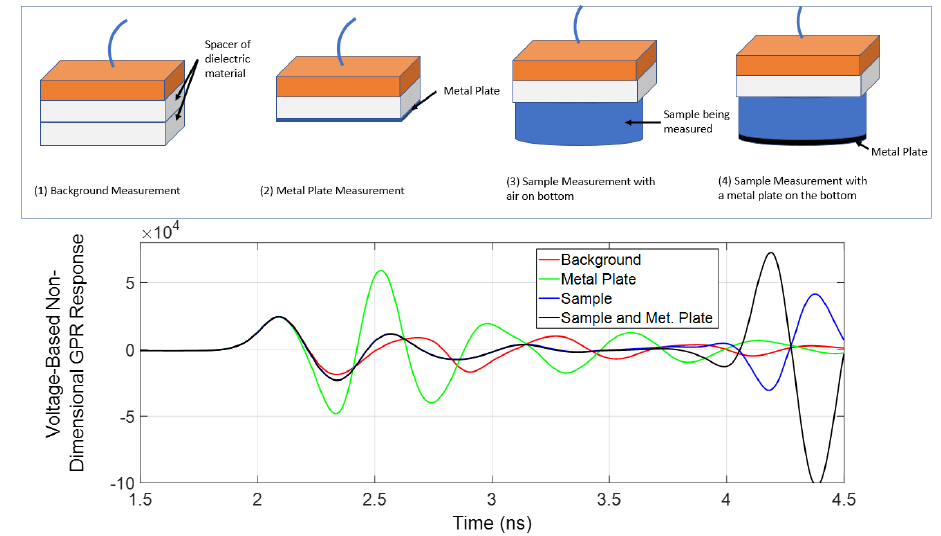
Figure 13. Four different measurement setups for travel-time based dielectric ( top ) and examples of the corresponding scan data ( bottom ).